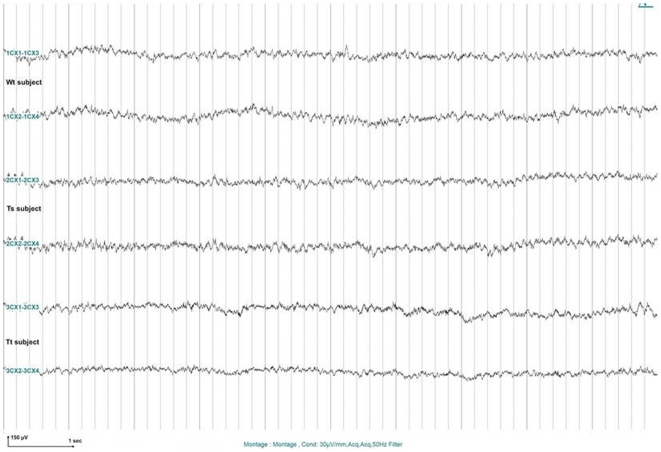
Electrocorticographic activity of 2n, Ts and Tt mice.Trace from left and right hemisphere show normal cortical activity. Calibration: 30 µV/mm.